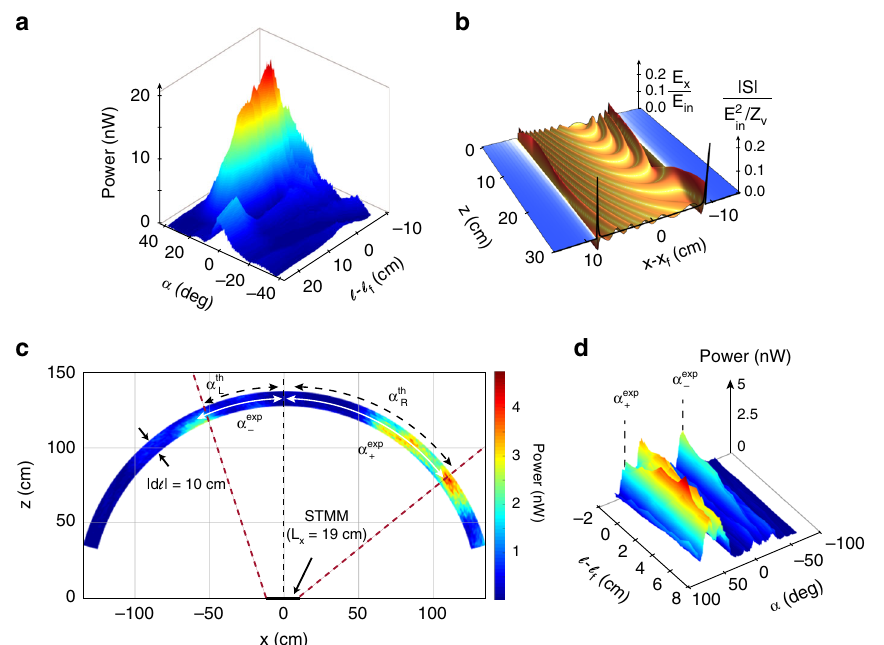
Fig. 4 Surface-wave-assisted nonreciprocity in focusing. a Measured re fl ected fi eld power at ω + 1 in the forward off-axis focusing experiment ( k in = 0). ; ω þ Ω Þ ! ð(cid:2) 2 ∇ φ focus ; ω Þ for the in fi nite- b Calculated snapshot of the re fl ected electric fi eld distribution for the reverse scattering process ð(cid:2) ∇ φ focus (cid:2) n ¼þ (cid:2) n ¼þ 1 1 in in sized STMM. The black line represents the time-averaged Poynting vector for the same scattering process. c Measured power at ω in in the far- fi eld for the reverse process is mainly con fi ned within the wedge-shaped region. Data at given radii of the arc sector correspond to different locations ‘ of the monopole source. Indicated are the calculated main directions of radiative emission from the right and left edges of the STMM and angles subtended between their ¼ þ 53 : 27 (cid:6) and α th ¼ (cid:2) 20 : 36 (cid:6) . The measured scanning angles for the main peaks on the crossings with the arc and its center, respectively given by α th R L right-side and left-side are α exp þ ¼ ðþ 54 ± 1 Þ (cid:6) and α exp (cid:2) ¼ ð(cid:2) 26 ± 1 Þ (cid:6) . d Same as c but as a function of the scanning angle and ‘ . Parameters are x f = 6 cm and z f = 15 cm ð ‘ ¼ 16 cm Þ . In all panels ω = 2 π × 6.9 GHz and Ω = 2 π × 50 f in